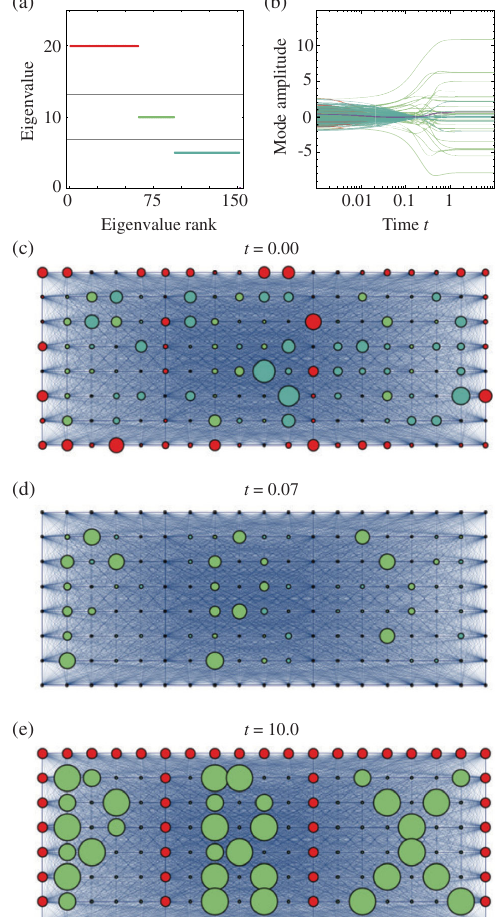
FIG. 4. Controlling pattern formation with a designed discrete band gap (Video 3 in Supplemental Material [56]). (a) Instead of placing a gap in the spectrum around the unstable pattern-forming range, as in Fig. 3, we deliberately place particular eigenvalues in the middle of that range corresponding to eigenvectors localized on a desired pattern. (b) From random initial conditions, the system settles into a state where only the chosen modes have non- negligible amplitudes. (c) – (e) Time series of pattern evolution on a designed network, with vertices colored according to the stability of the mode localized there as in (a). The size of the vertices indicates j u j . (c) The encoded pattern is not obvious from either the designed network or the random initial conditions. (d) By time t ¼ 0 . 07 the stable modes have nearly all vanished. (e) The steady state reveals the eigenmode-designed pattern. Because the modes are highly localized, selecting a set of modes to activate is approximately equivalent to selecting a set of vertices to activate. Thus, we can encode an arbitrary pattern as the steady state. Depending on initial conditions, the system may settle into other stable states with slight variations in the vertex activations; the picture typically shows up at least as clearly as it does here and often is more uniform. The parameters α ¼ 90 , D 1 ¼ − 20 , and D 2 ¼ 1 were identical to those in Fig. 3; the tuning parameters to control pattern formation are only the network edge weights. See Video 3 in Supplemental Material [56] for animation and other initial